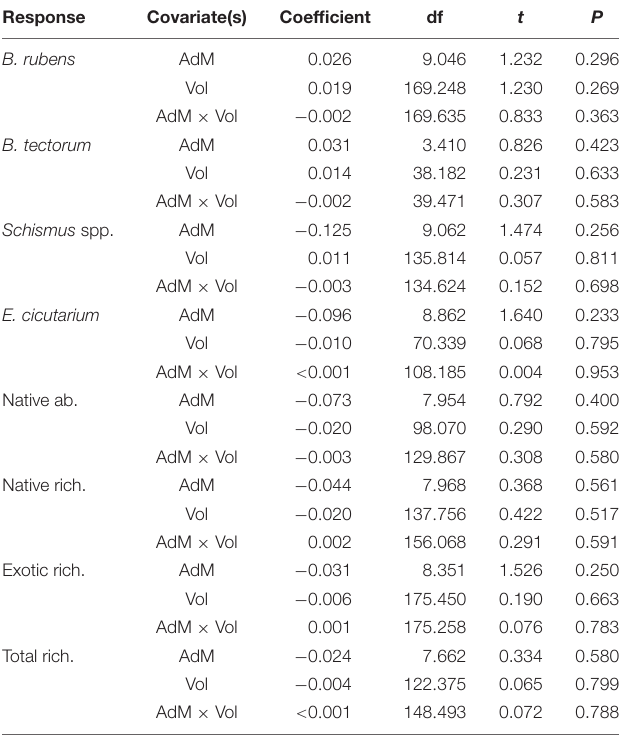
TABLE 1 | Results of linear mixed-effects models with RII as the response variable; de Martonne aridity score (Adm), shrub volume (Vol), and their interaction (AdM × Vol) as covariates; and shrub species nested within site as a random effect (not shown). Response